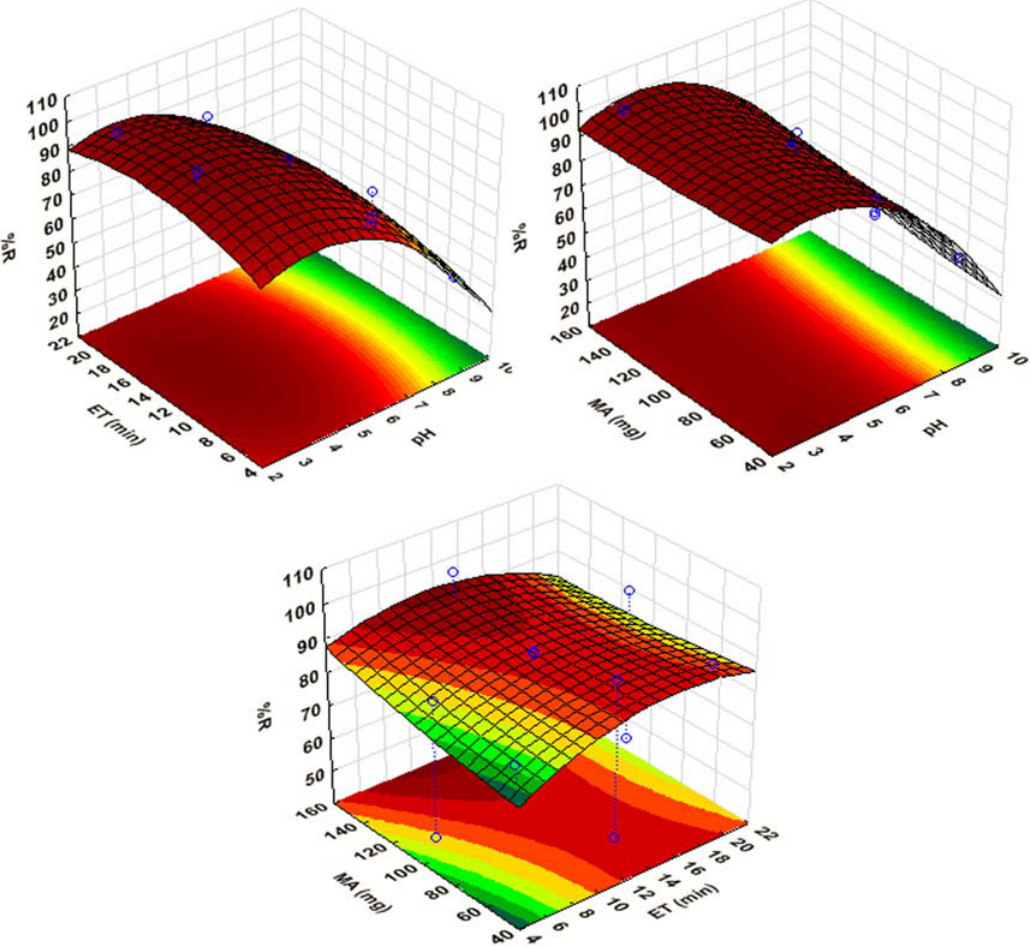
Figure 7: Three - dimensional response surface plots for the preconcentration of Te as a function of experimental